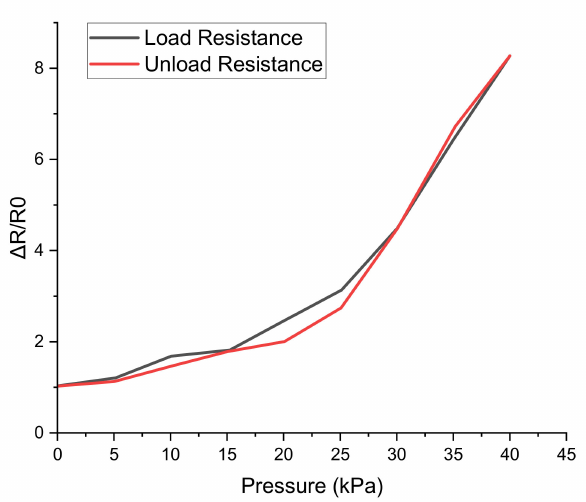
Figure 17. Hysteresis testing of manufactured bump-type EGaIn soft